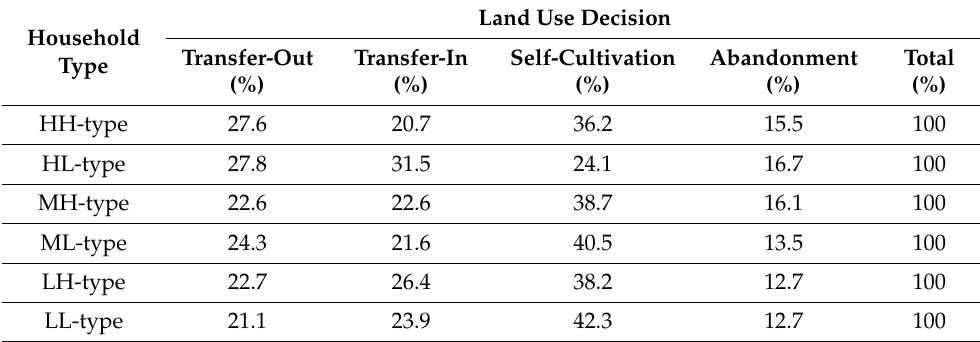
Table 8. Ratio of different land use household